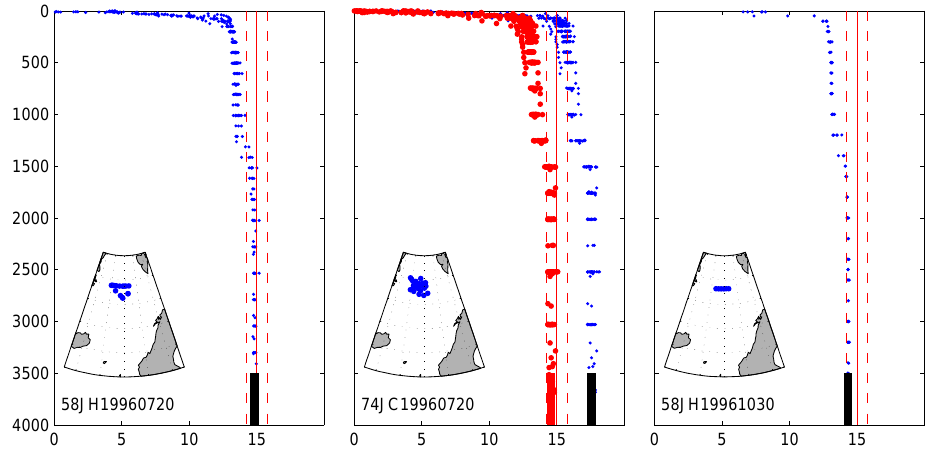
Figure 5. Greenland Sea (73–89 ◦ N, 25 ◦ W to 3 ◦ E) nitrate profiles from 74JC19960720 with (red) and without (blue) corrections applied, along with data from the previous and subsequent cruises. The thick vertical bars at bottom show mean values deeper than 1900 dbar. For reference, red solid and dashes lines have been drawn at 15 µ molkg − 1 ±